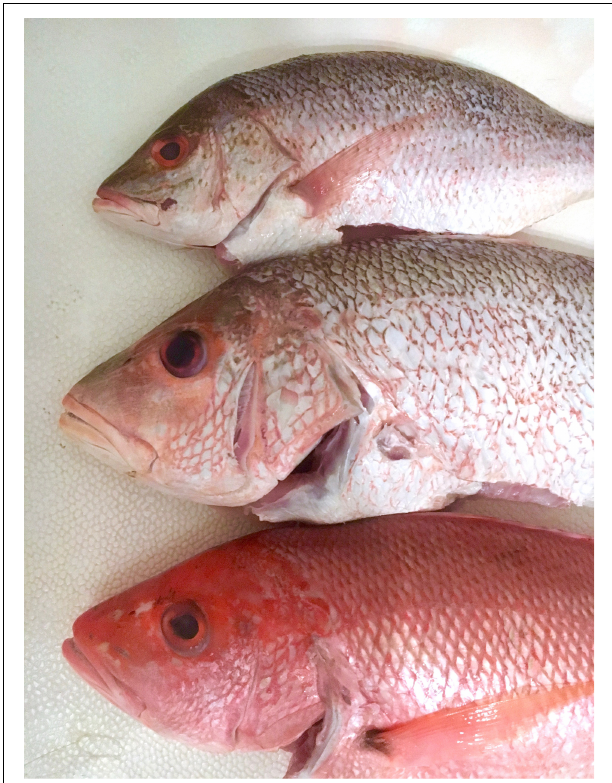
FIGURE 2 | Many snapper species are difficult to tell apart, even as whole fish. For example, lane snapper (top) resembles red snapper (middle). There is also variation in coloration of red snapper, as seen in the two red snapper samples (middle and bottom), which makes positive identification even more